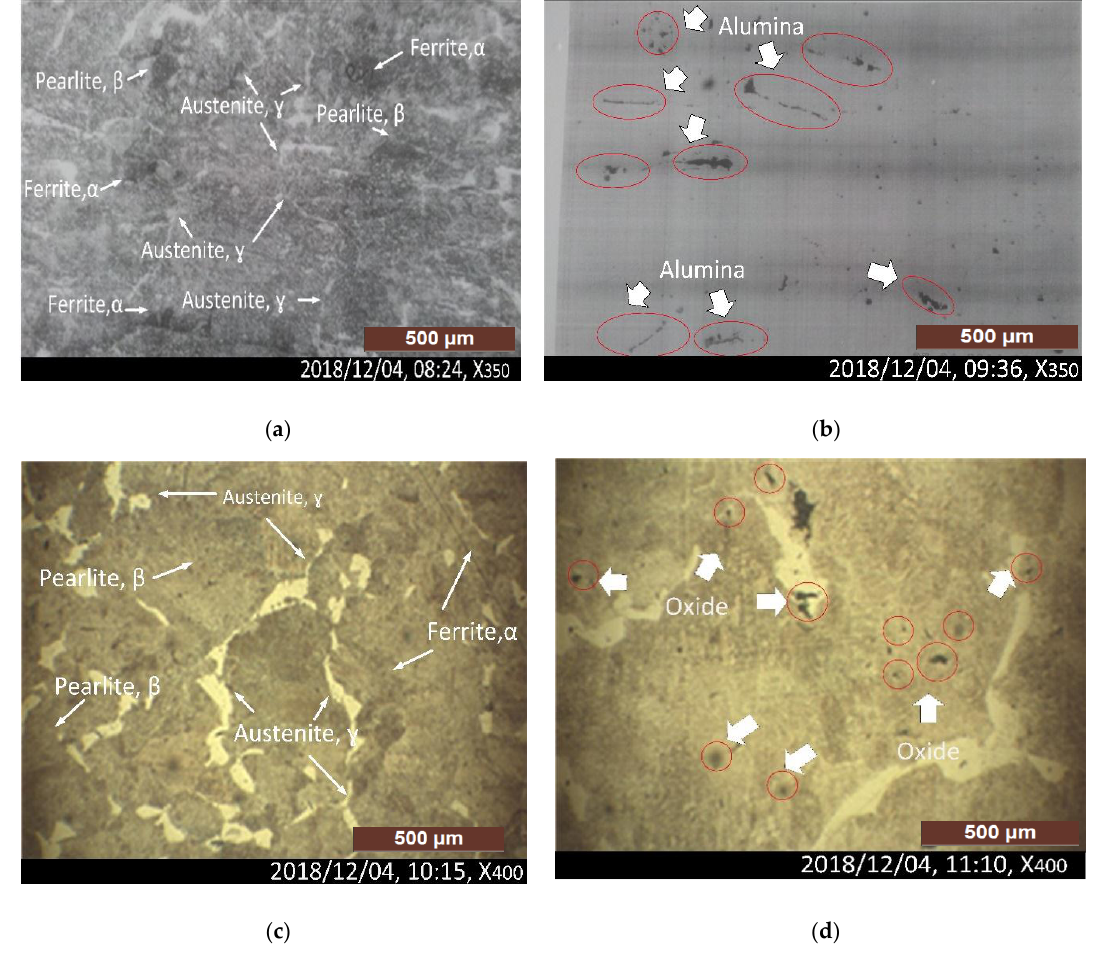
Figure 9. ( a ) As-cast structure of ferrite within the fine pearlite matrix and at prior austenite grain boundaries, at a magnification of ×350; ( b ) Not-etched micro alumina-type inclusions are observed as per ASTM E-45, at a magnification of x350; ( c ) A fine matrix structure of ferrite within the fine pearlite matrix and at prior austenite grain boundaries, at a magnification of x400; ( d ) Not-etched micro oxide-type inclusions, at a magnification of ×400.